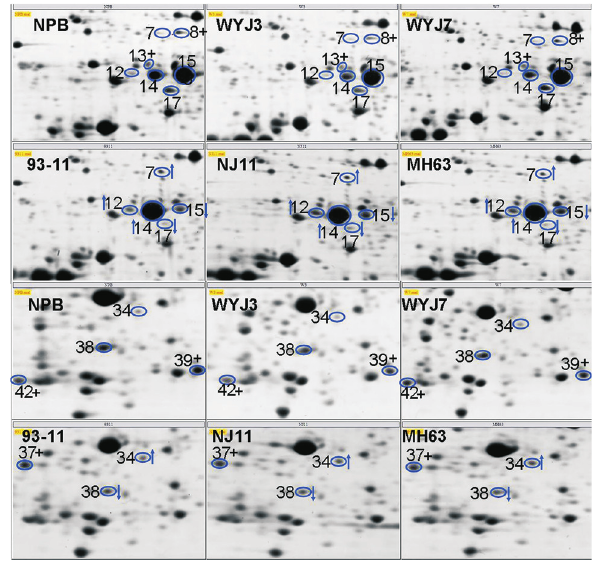
Figure 6 - Enlarged views of the unique proteins (spots 8, 13, 37, 39 and 42) in indica and japonica rice varieties. Indica rice varieties: 93-11, NJ11 – Nanjing 11, MH63 – Minghui 63. Japonica rice varieties: NPB – Nipponbare, WYJ3 – Wuyujing 3 and WYJ7 – Wuyunjing